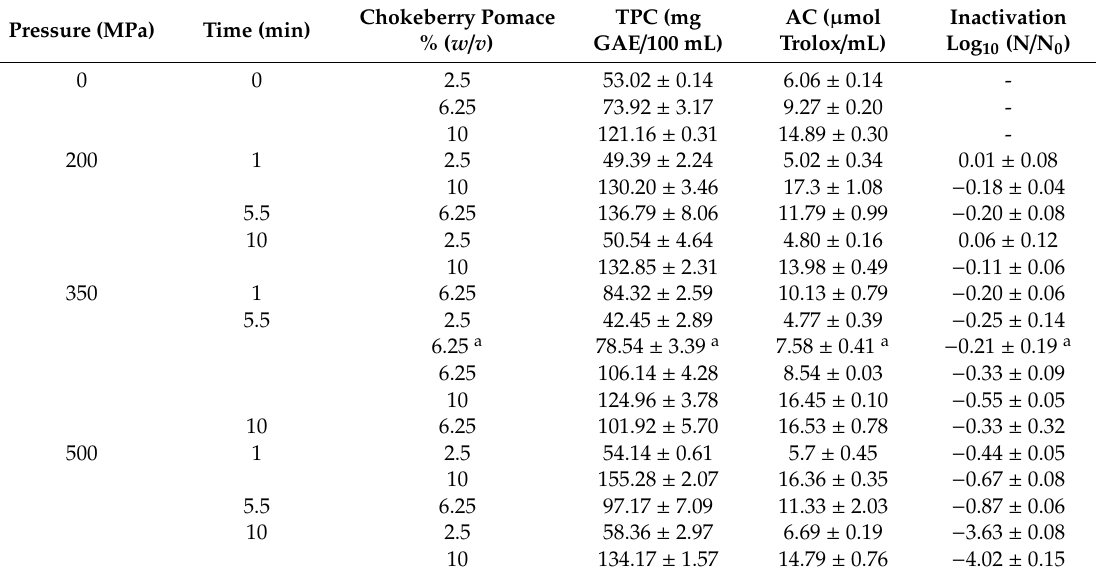
Table 2. E ff ect of HPP and chokeberry pomace on TPC, AC, and the microbial survival